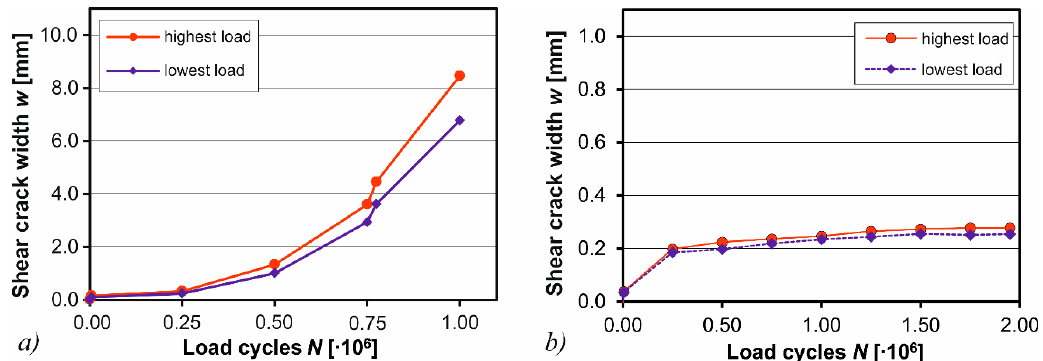
Figure 14. Shear crack widths w according to digital image correlation for ( a ) M-22-7 and ( b ) CTRM-M-22-7.